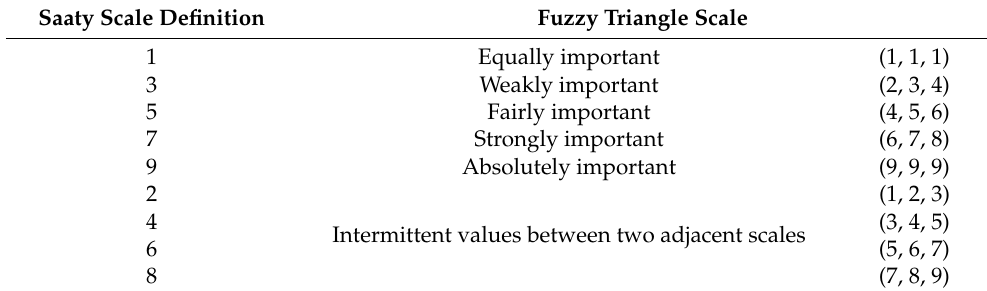
Table 2. TFN scale.